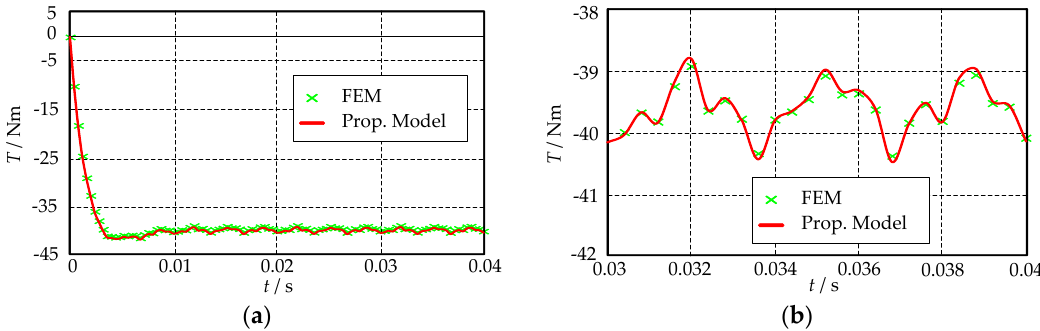
Figure 9. Electromagnetic torque and its pulsating torques of the proposed DRRF generator at full load: ( a ) Electromagnetic torque; ( b ) Pulsating torques in the electromagnetic torque.